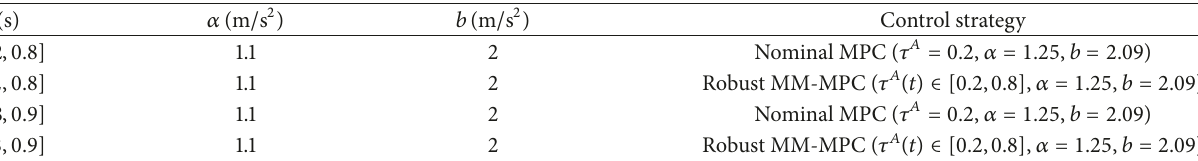
Table 2: Simulation scenarios for a heterogeneous platooning control test.